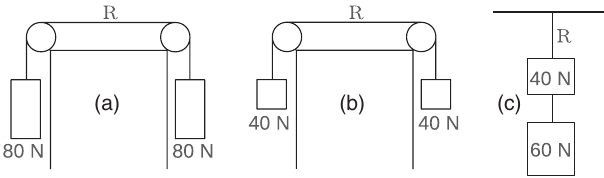
FIG. 6. Pictures from the problem labeled with circles ( (cid:5) ) in Figs. 4 and 5. The problem is adapted from Ref. [4].